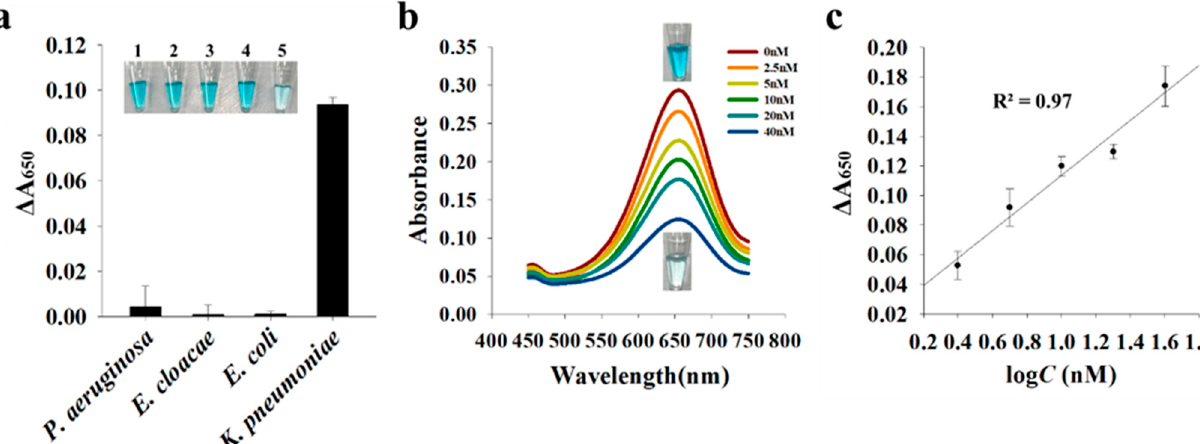
Figure 6. Detection selectivity ( a ) and sensitivity ( b , c ) of the proposed system. ( a ) Change in absorbance signal ( ∆ A 650 ) was calculated by subtracting A 650 in the presence of target DNA from that in the absence of target DNA. Inset shows a photographic image of each sample containing PCR products. 1: the absence of target DNA; 2: Pseudomonas aeruginosa ; 3: Enterobacter cloacae ; 4: Escherichia coli ; 5: Klebsiella pneumoniae. ( b ) Absorbance spectra in the presence of PCR products at different concentrations and images of a control sample without PCR products and a sample containing 40 nM PCR products. ( c ) Linear relationship between ∆ A 650 and PCR concentration (2.5–40 nM).